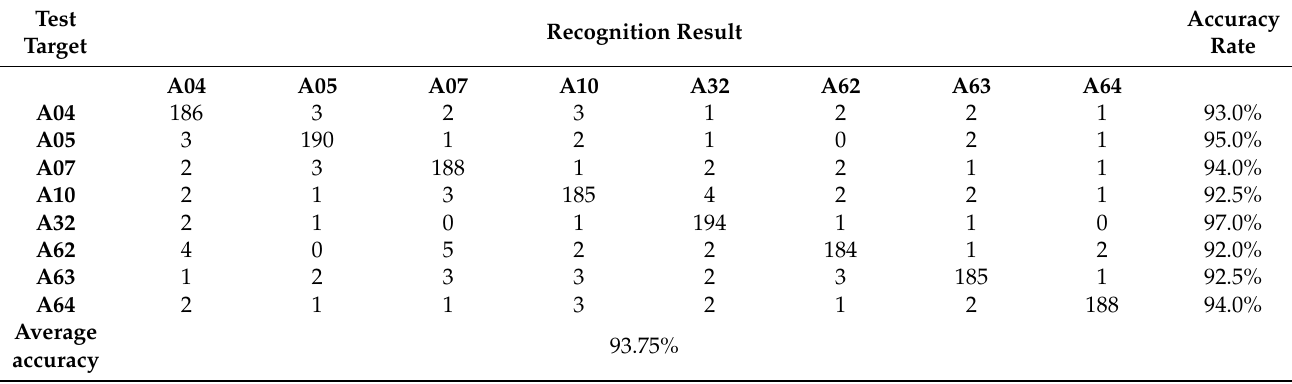
Table 6. Target recognition results with pretraining (T72 dataset).